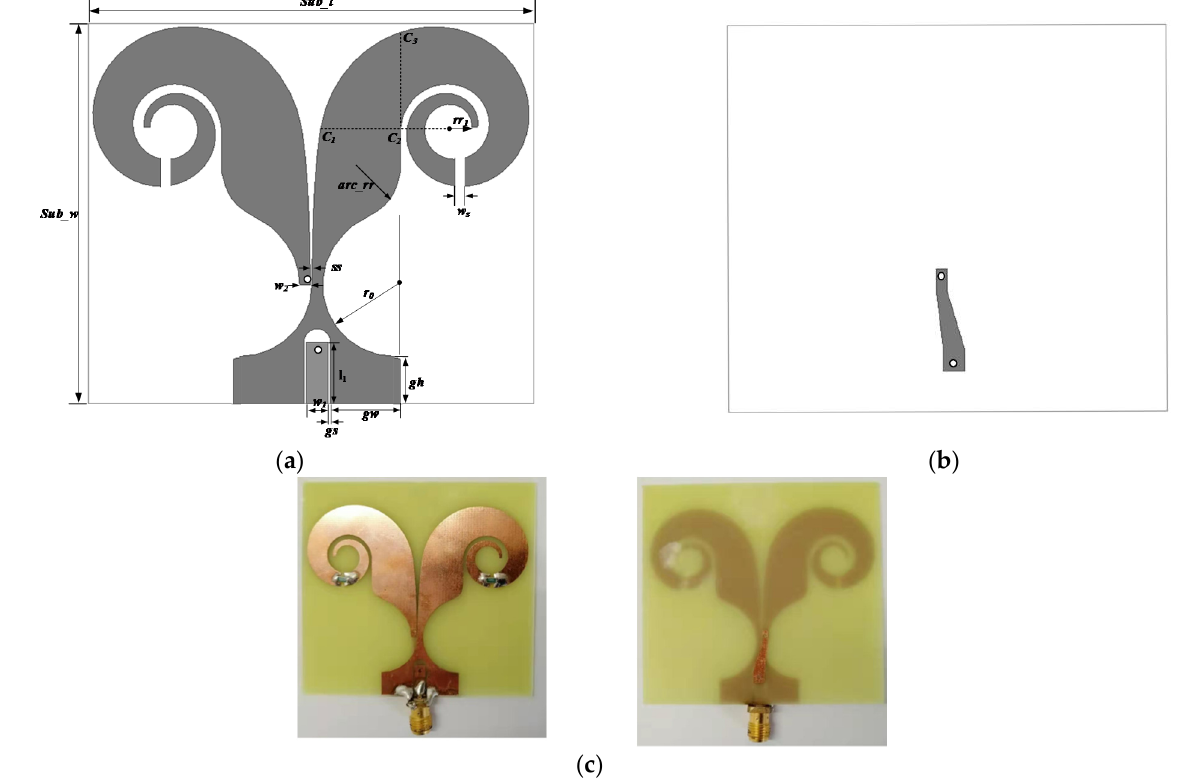
Figure 1. Geometry of the antenna: ( a ) top view, ( b ) bottom view, and ( c ) fabricated antenna model.